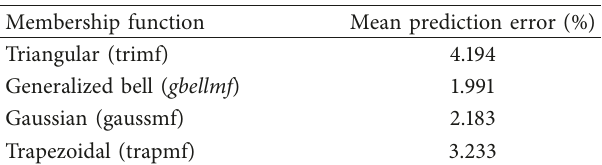
Table 2: Mean prediction error for different types of membership